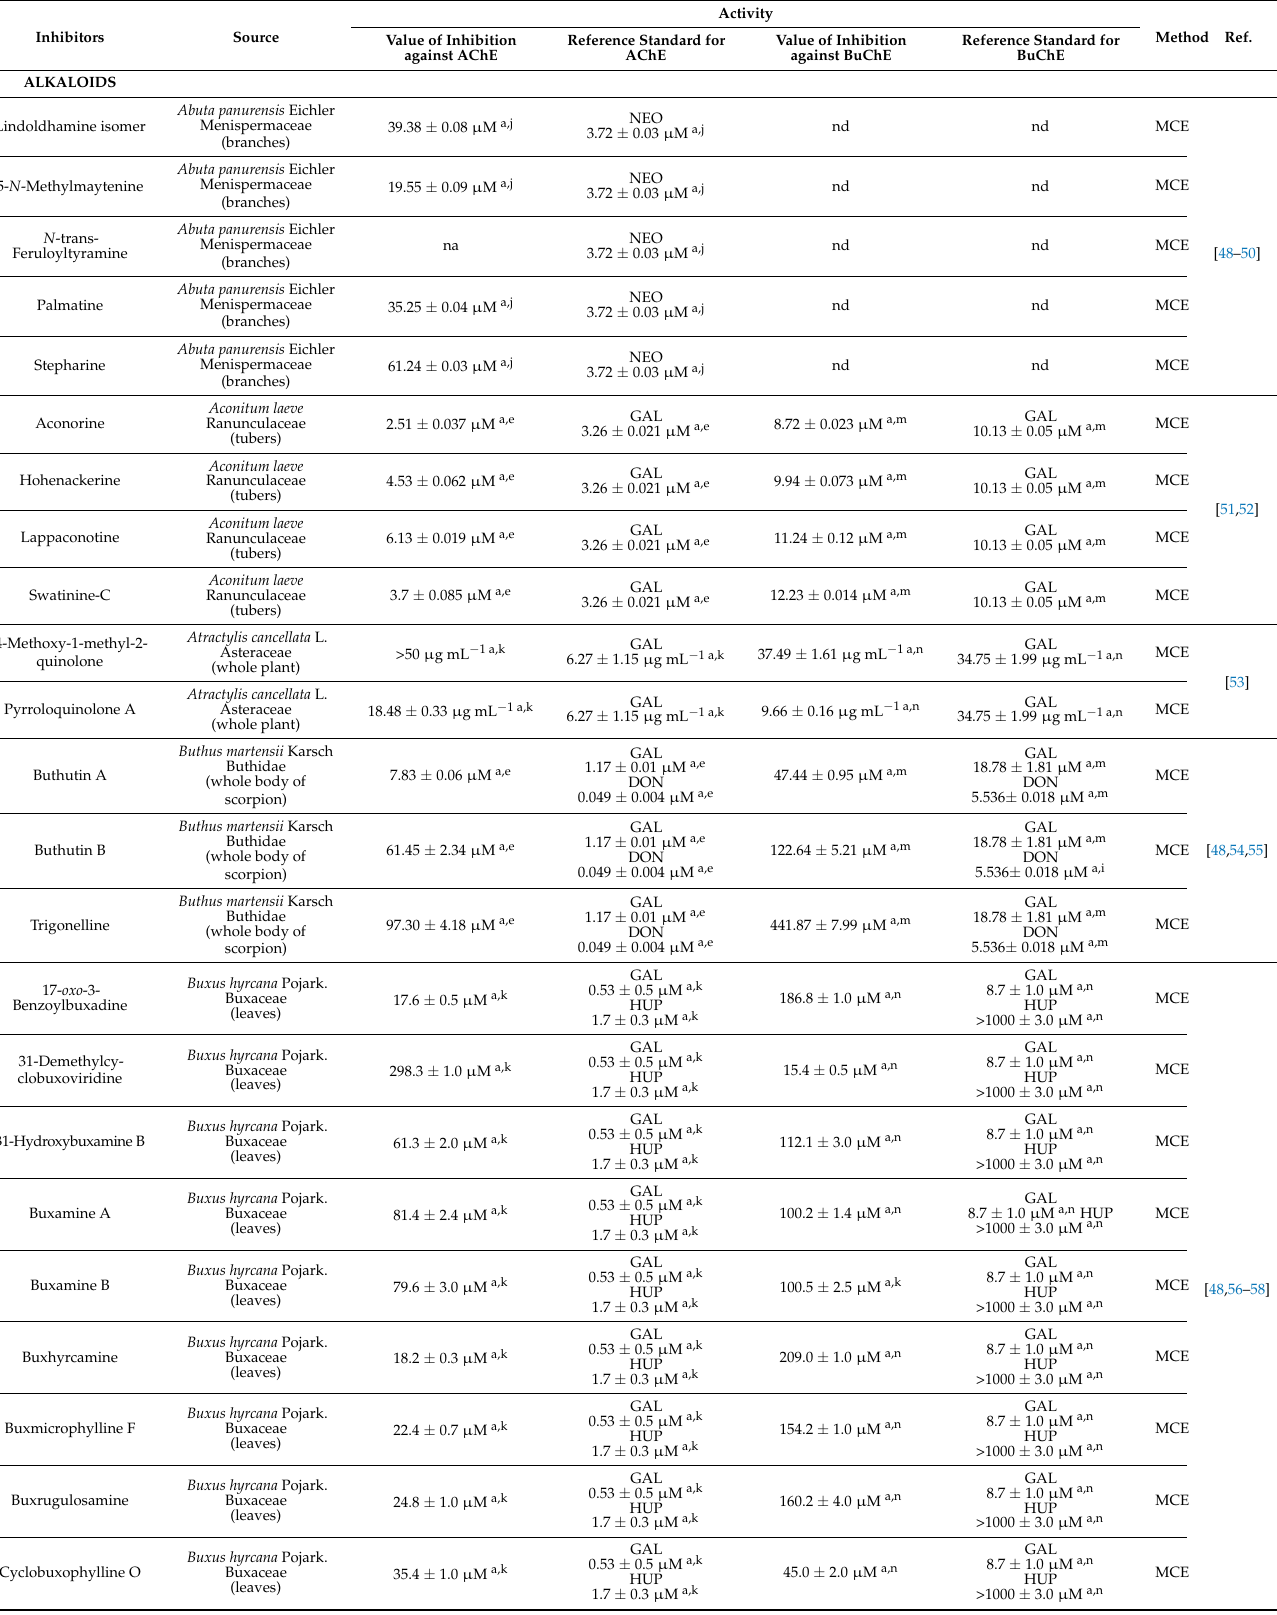
Table 1. Inhibitors’ classification in terms of their affiliation with a group of compounds, their effects on AChE and BuChE, their activity, their origins and the methods of their analysis.